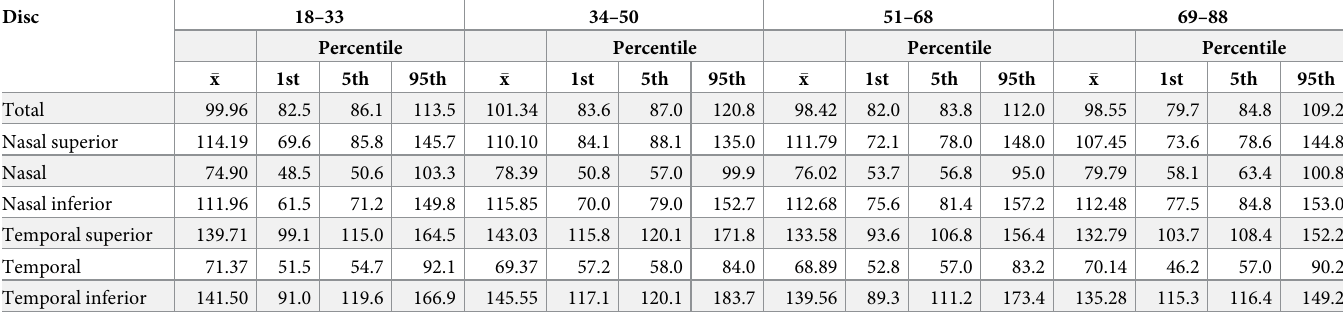
Nasal outer Superior inner Superior outer Temporal inner Temporal outer Inferior inner